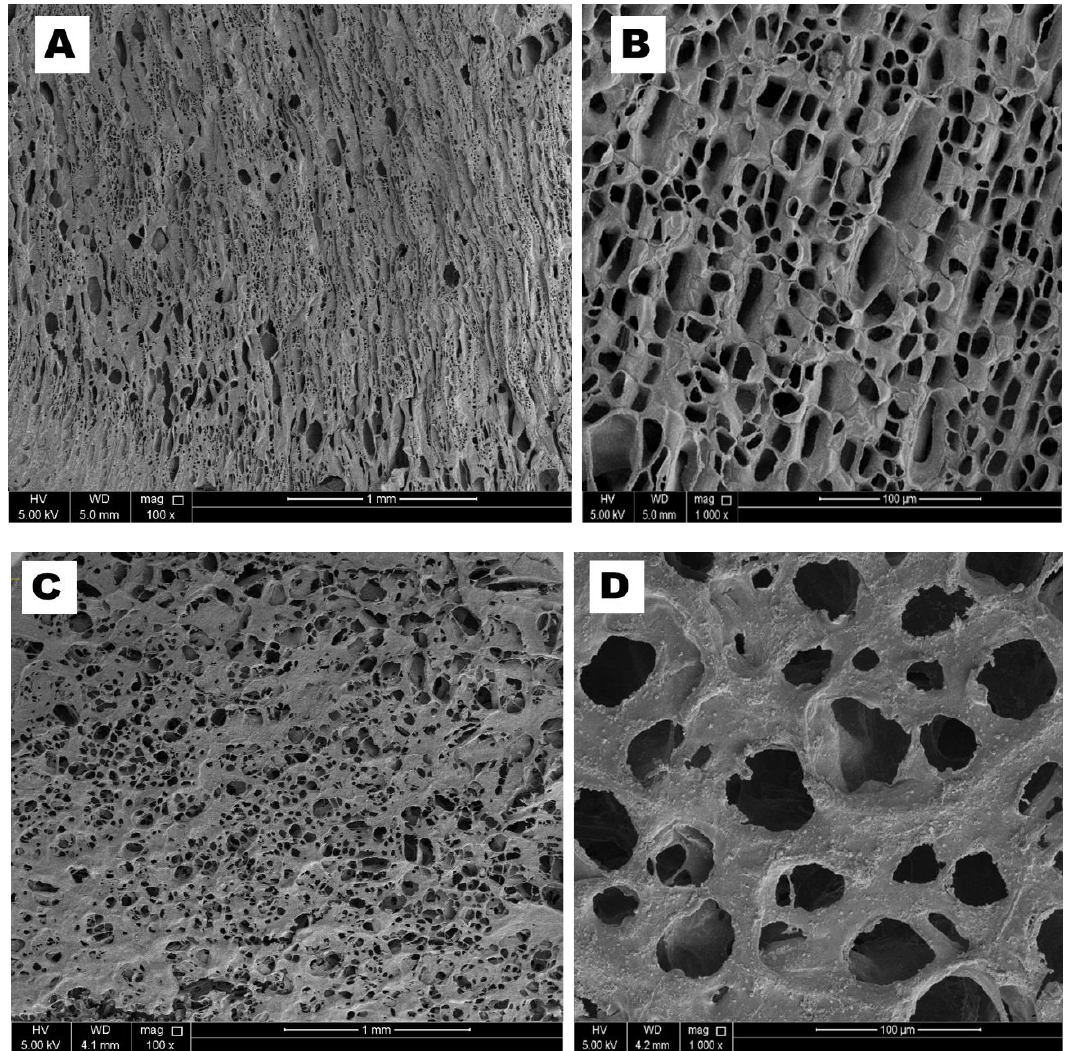
Figure 4. SEM images of the as-prepared ( A , B ) 2% sodium alginate aerogel ( C , D ) SAHA aerogel with different magnifications.